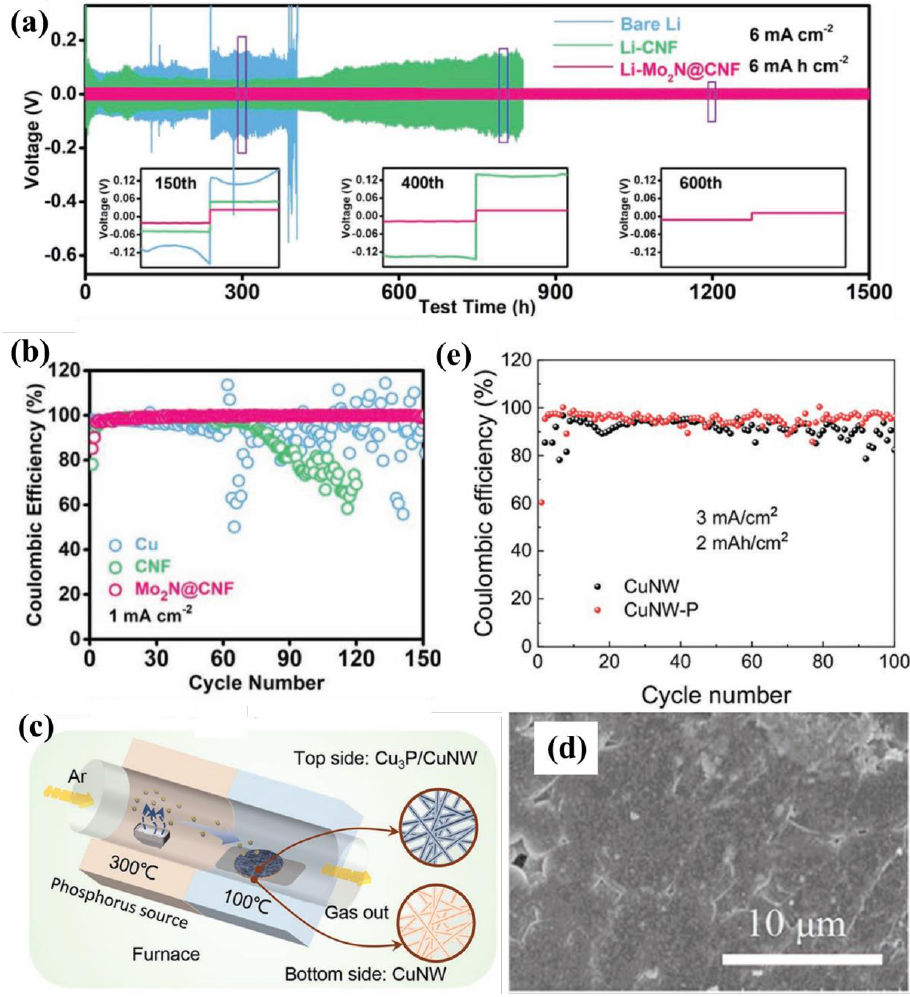
Figure 5. ( a ) Cycling performance of Li, Li-CNF, and Li-Mo 2 N@CNF in symmetric cells at 3 mA cm − 2 ; ( b ) Coulombic efficiency of Li plating/stripping on Cu, CNF, and Mo 2 N@CNF at 1 mA cm − 2 , 1 mAh cm − 2